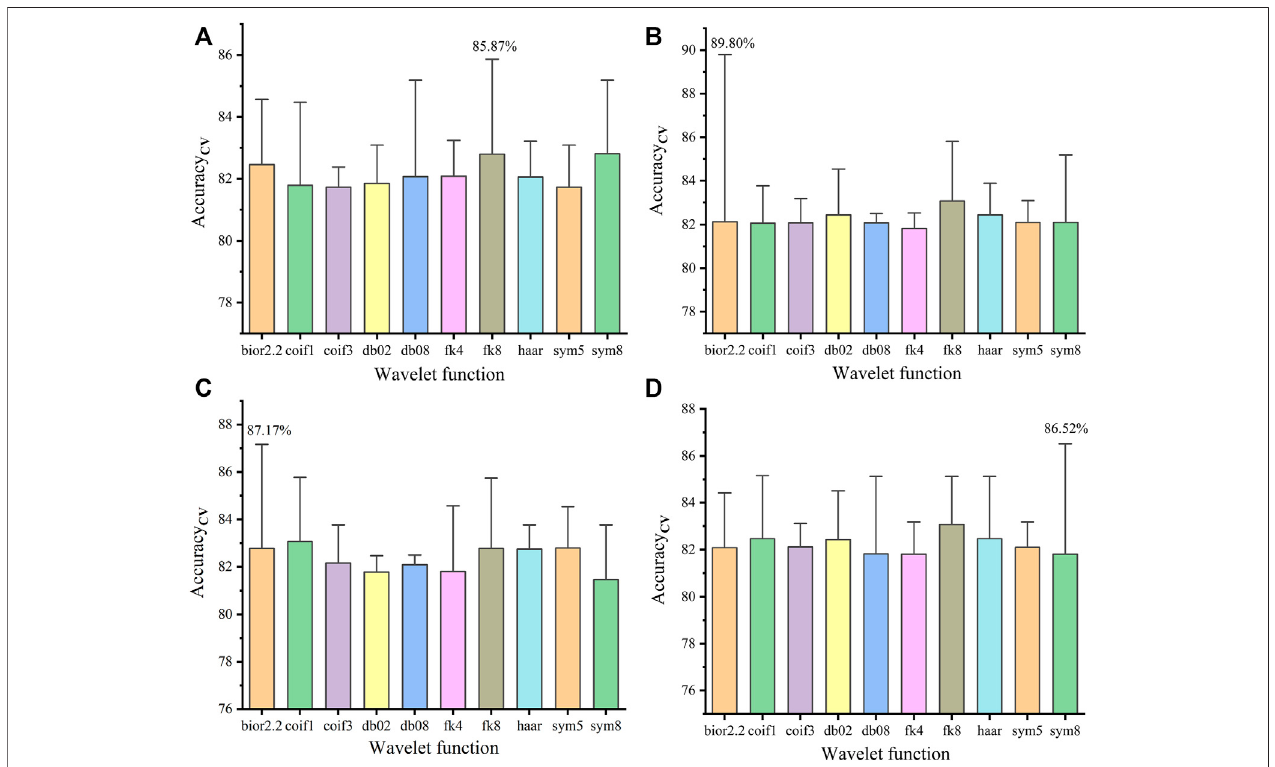
FIGURE 3 | Acc cv of the PLS-DA model using Raman spectral data processed by WTD in four thresholds: heursure (A) , minimaxi (B) , rigrsure (C) , and sqtwolog (D) .